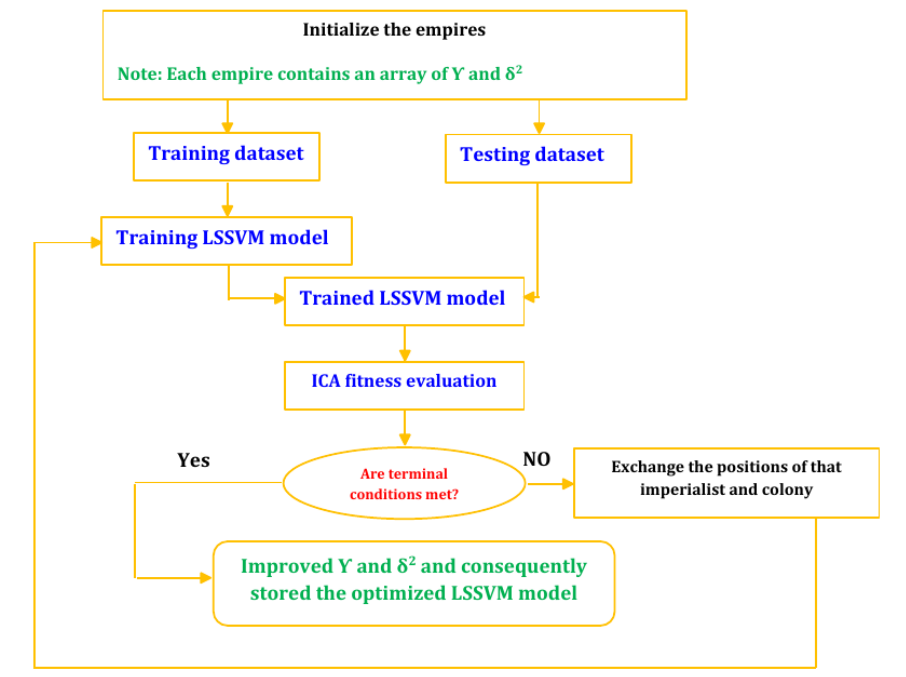
Figure 4. The overall scheme of the Imperialist Competitive Algorithm (ICA)-least squares support vector machine method [72].